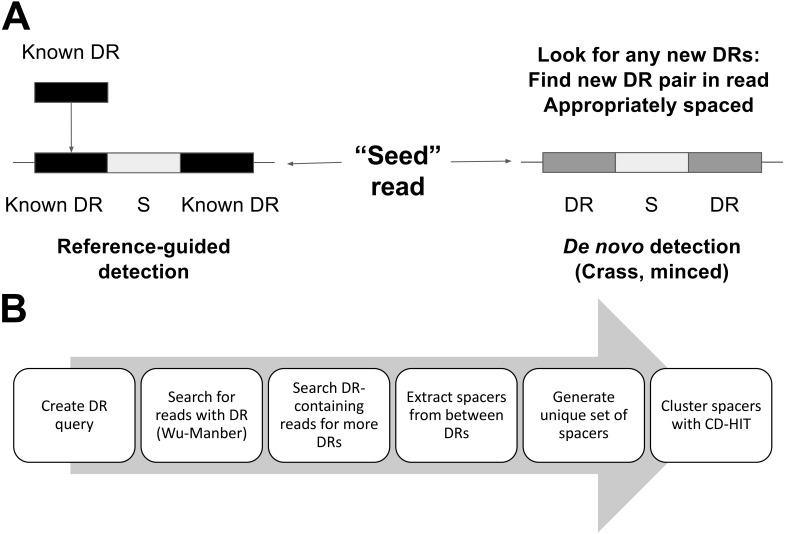
A comparison of per-read CRISPR detection strategies (A) between MetaCRAST and existing de novo detection tools (e.g., Crass, MinCED) and an outline of the MetaCRAST workflow (B).DR represents direct repeat, while S represents spacer.